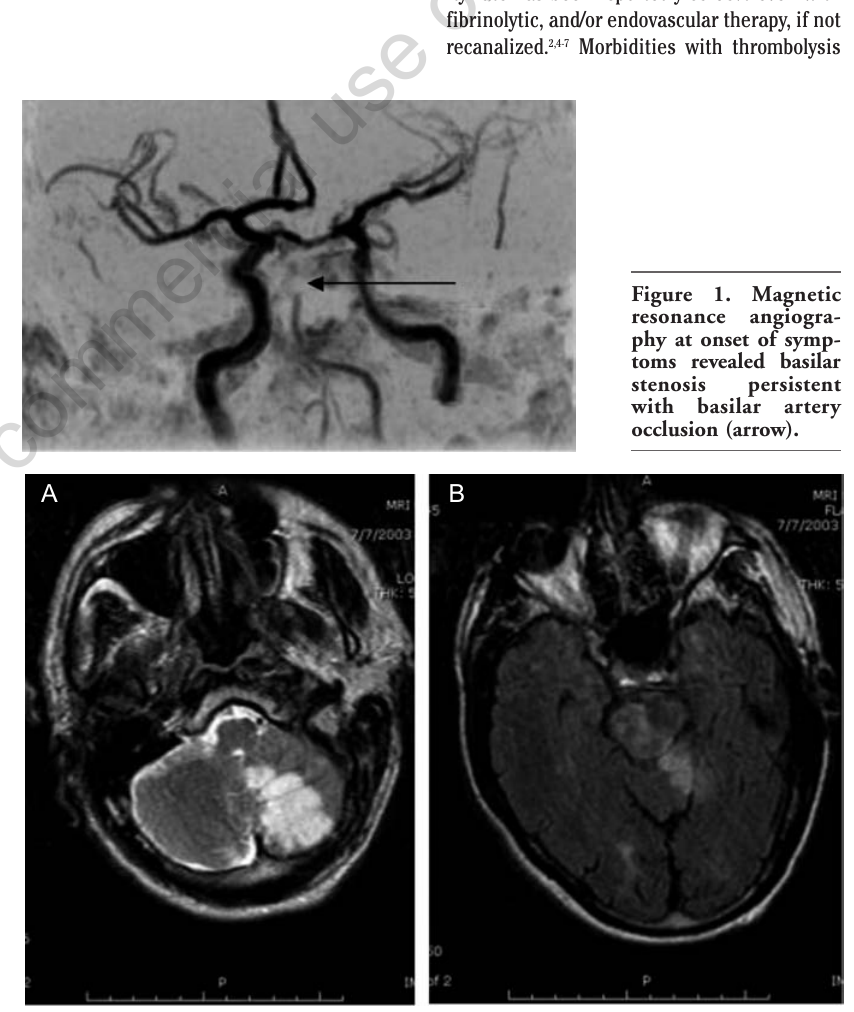
Figure 2. At the time of presentation, T2 weighted imaging showed infarcts in the cere- bellum (A) and axial FLAIR imaging showed infarcts in the brainstem